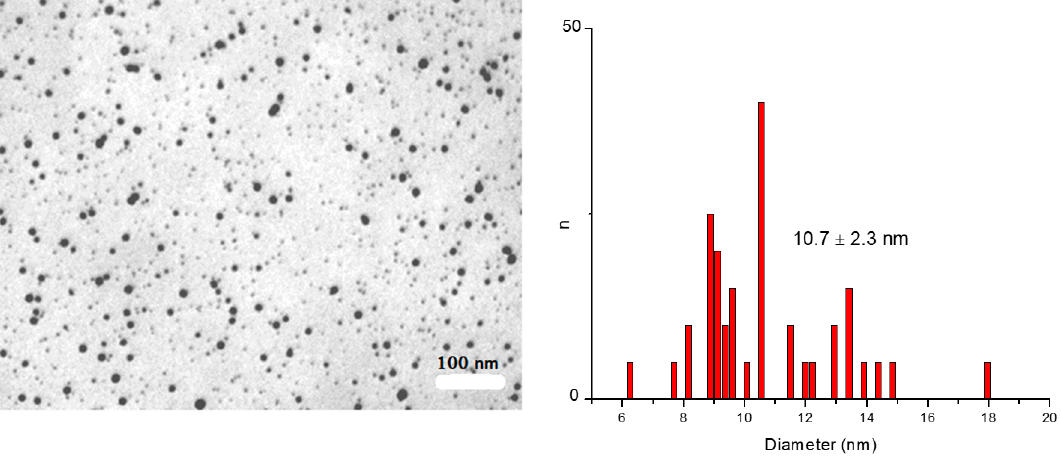
Figure 8. TEM micrograph of Pt-ascorbate nanoparticles synthesized for water photoreduction experiments.